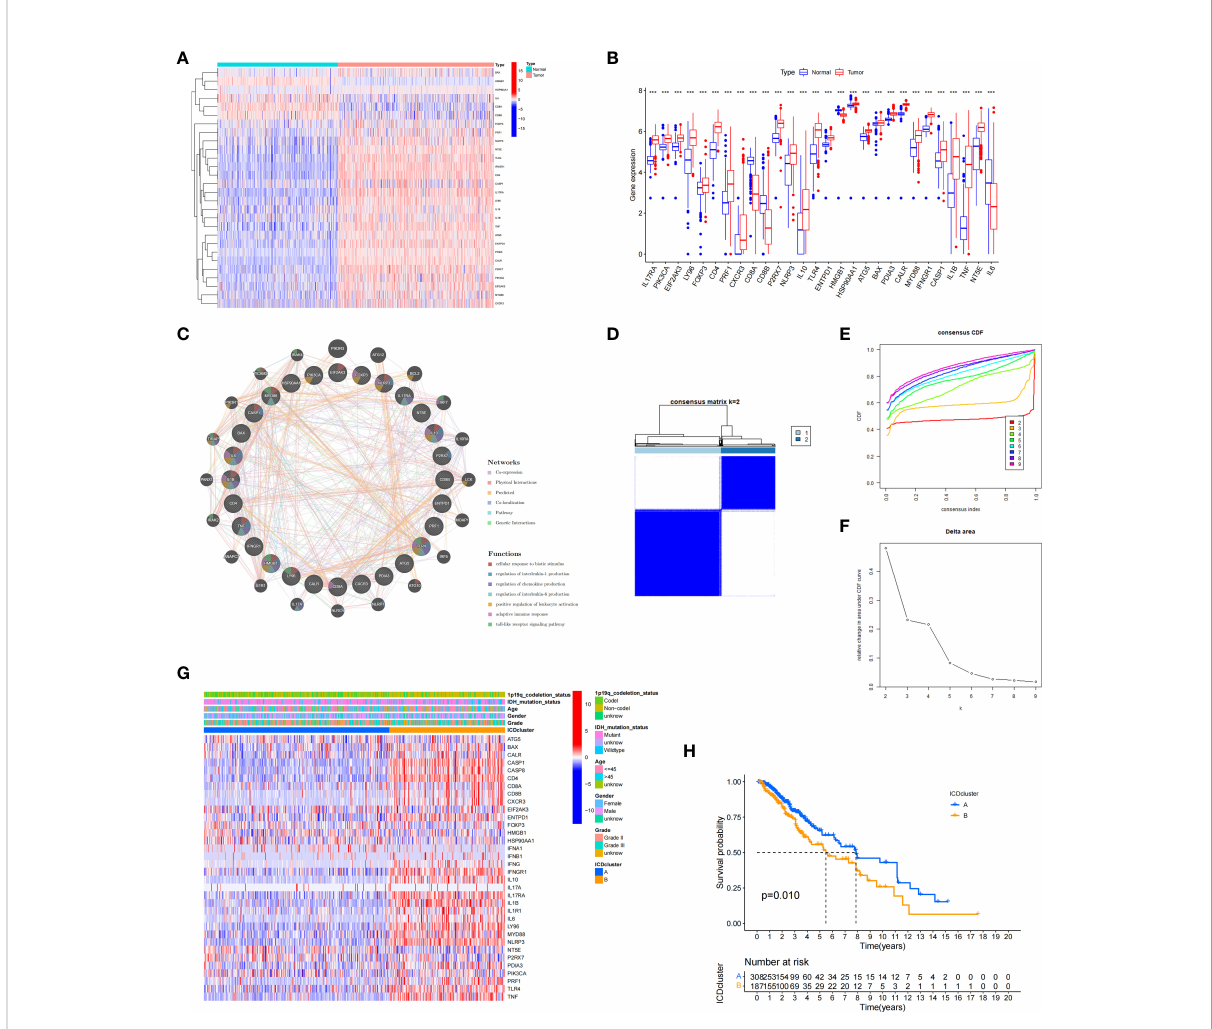
FIGURE 2 Expression patterns and consensus cluster of ICD-related genes. (A, B) Heatmap (A) and box plot (B) show 28 of 34 ICD genes with signi fi cantly different expression pro fi les between normal and LGG samples in TCGA and GTEx databases, ***P < 0.001. (C) Differentially expressed genes and their coexpressed genes were analysed via GeneMANIA. (D) Heatmap of consensus clustering solution (k = 2) for 34 genes in 529 LGG samples. (E, F) The delta area curve of consensus clustering indicates the relative change in the area under the cumulative distribution function (CDF) curve for k = 2 to 10. (G) Heatmap of the expression of 34 ICD-related genes in different subtypes. Red represents high expression, and blue represents low expression. (H) Kaplan – Meier curves of OS in Cluster A and Cluster B